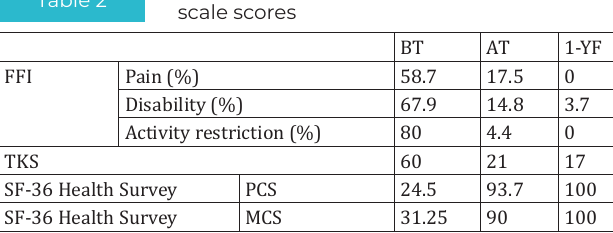
Improvement levels in FFI, TKS and SF-36